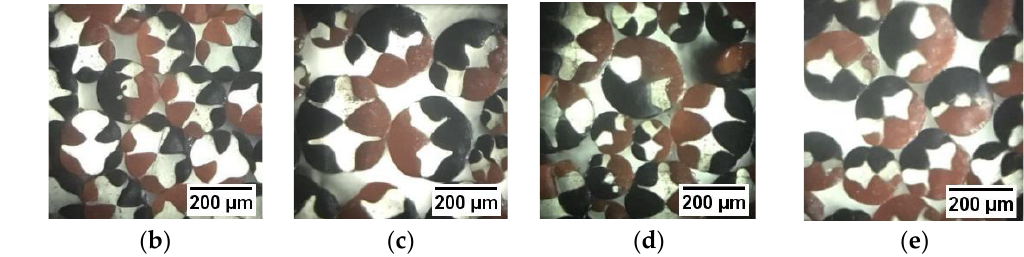
Figure 8. Cross- sections of “fishbone” fibers with different flow ratios. ( a ) The flow ratio is 1:2:1; ( b ) the flow ratio is 3:4:3; ( c ) the flow ratio is 1:1:1; ( d ) the flow ratio is 4:3:4; ( e ) the flow ratio is 2:1:2.